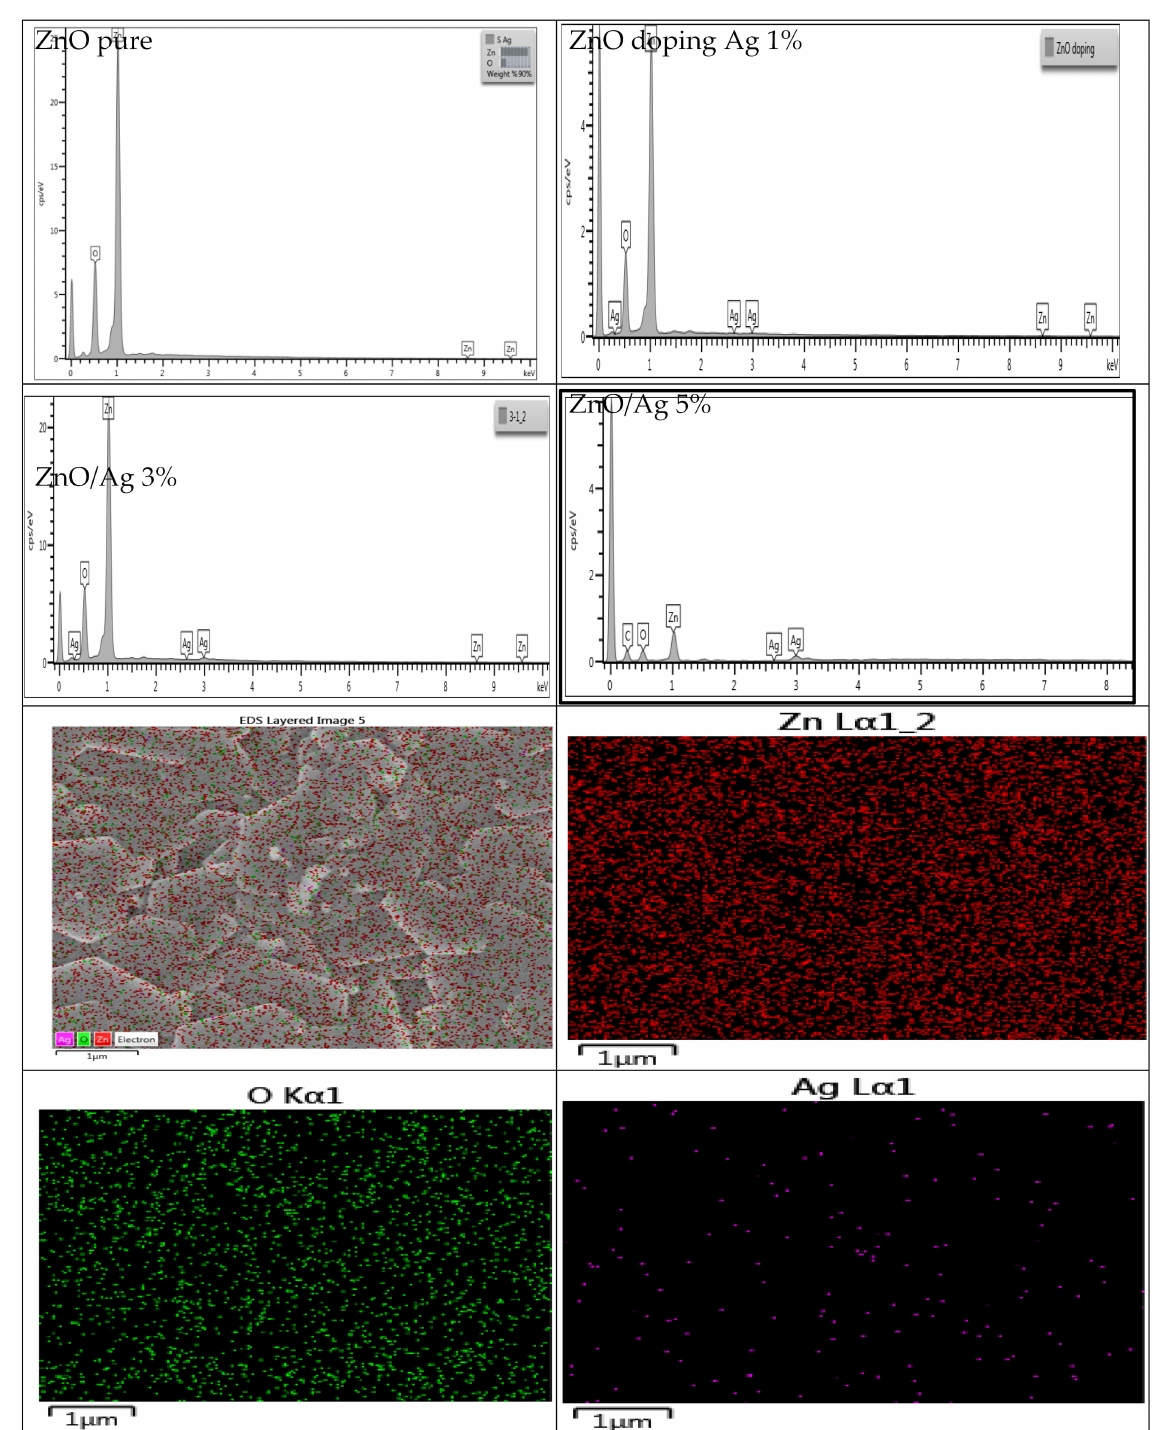
Figure 4. The EDX spectrum for undoped and Ag-doped ZnO thin films with typical mapping